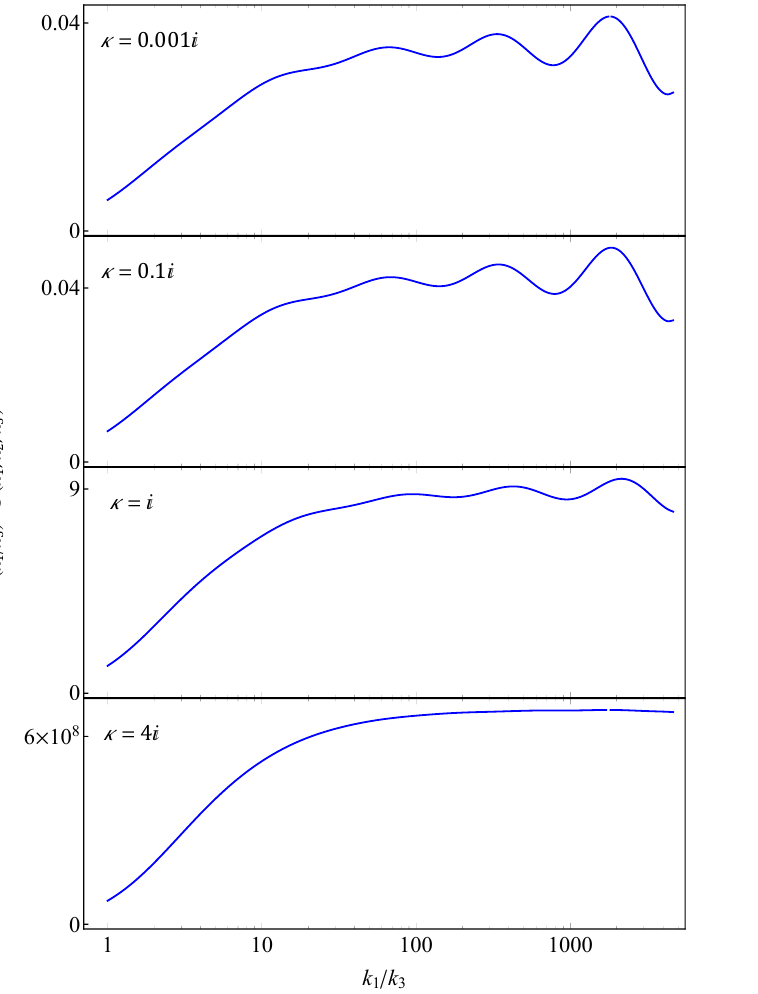
Figure 11 . The (cid:12)gure shows the clock signal from the bispectrum for m = 4 H 2 . Here we set k 3 z =k 3 = 1 again. We can see the suppression of the clock signal as the electric (cid:12)eld